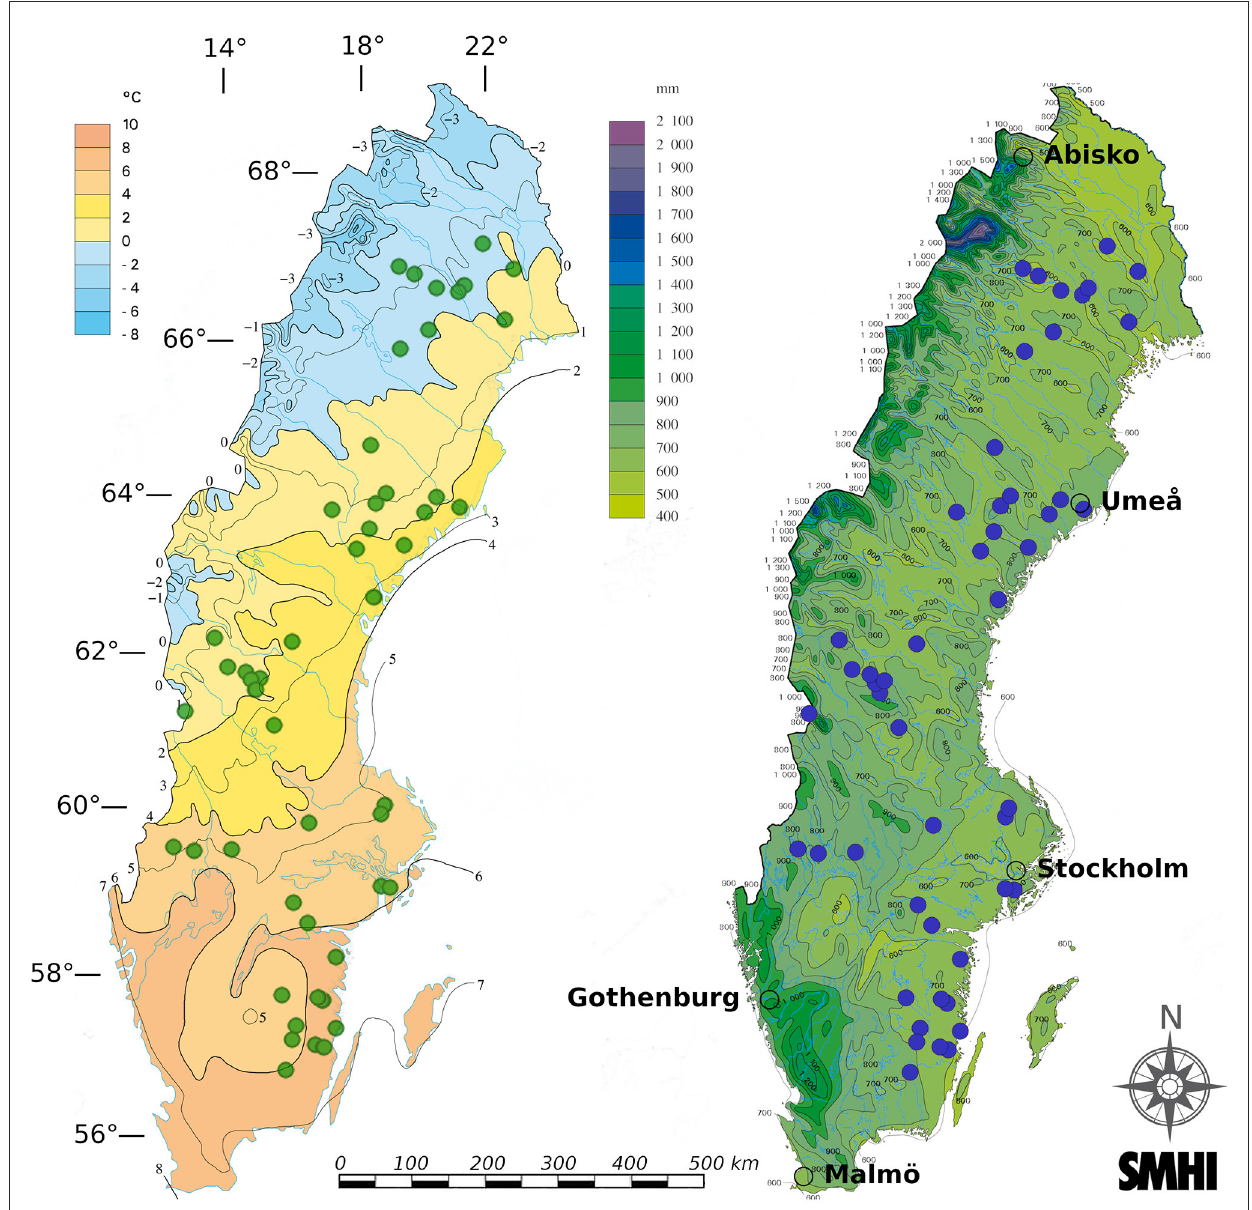
FIGURE2 The 50 plot pairs spanned the approximately 57–67 latitudinal range within Sweden. They are seen as colored points on figures provided by the Swedish Meteorological and Hydrological Institute (SMHI) of mean annual temperature (left) and mean annual precipitation (right) over the last normal period 1961-1990. Major cities/research centers are marked with empty circle perimeters and WGS 84 (EPSG:4979) latitudes (horizontal bars) and longitudes (vertical bars) are given in